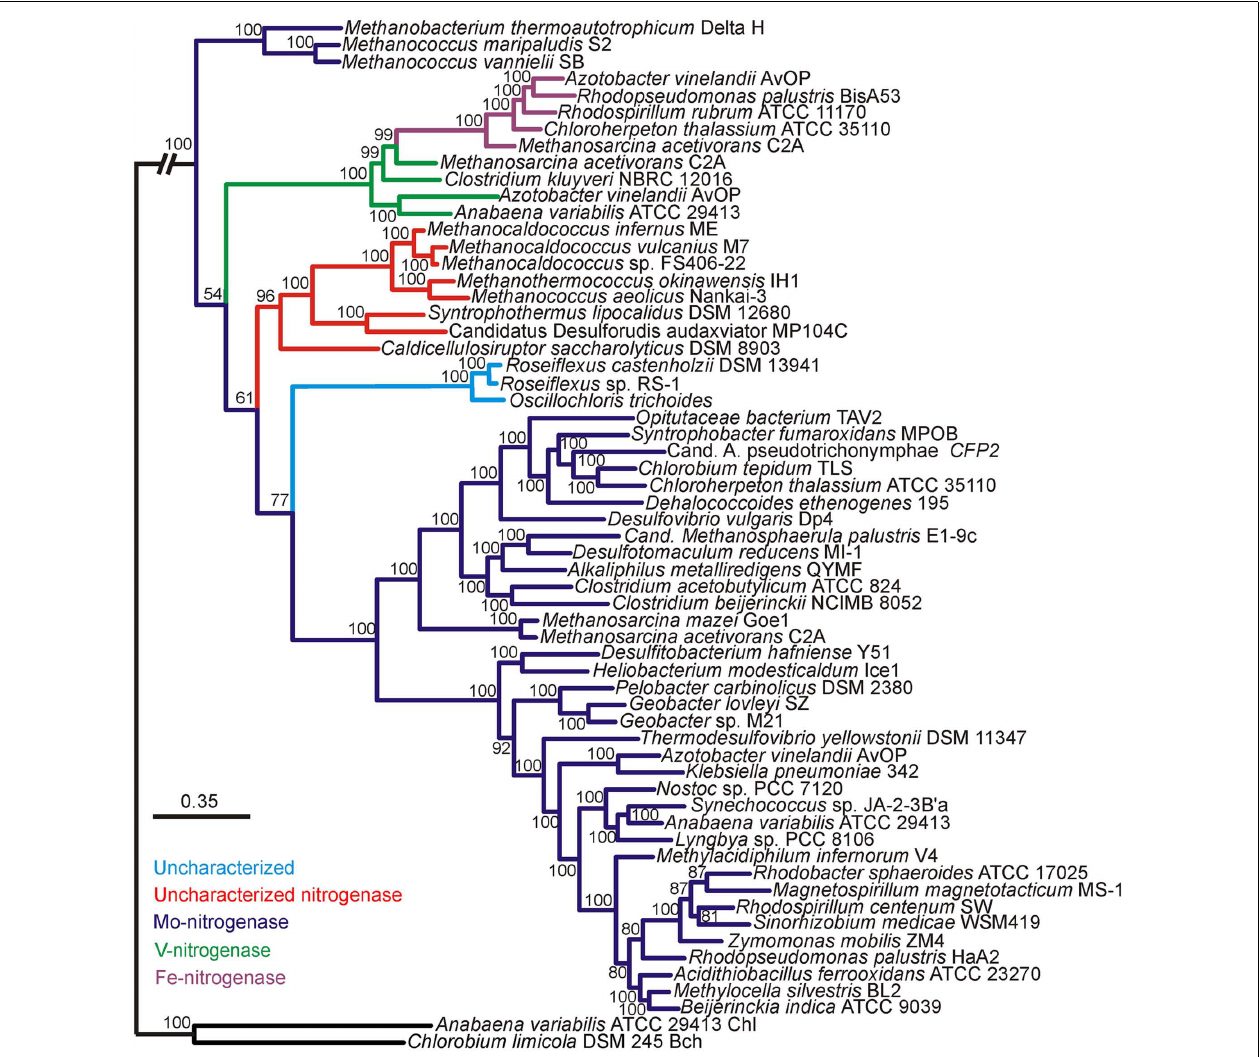
FIGURE 1 | Bayesian inferred phylogenetic tree of concatenated HDK homologs (see FigureA1 inAppendix for maximum-likelihood inferred tree). Posterior probabilities are indicated above or below nodes. Branches are colored dark blue (Mo-nitrogenase, Nif), green (V-nitrogenase,Vnf), purple (Fe-nitrogenase, Anf), red (uncharacterized nitrogenase), and light blue (uncharacterized homolog).The hash at the root was introduced to conserve